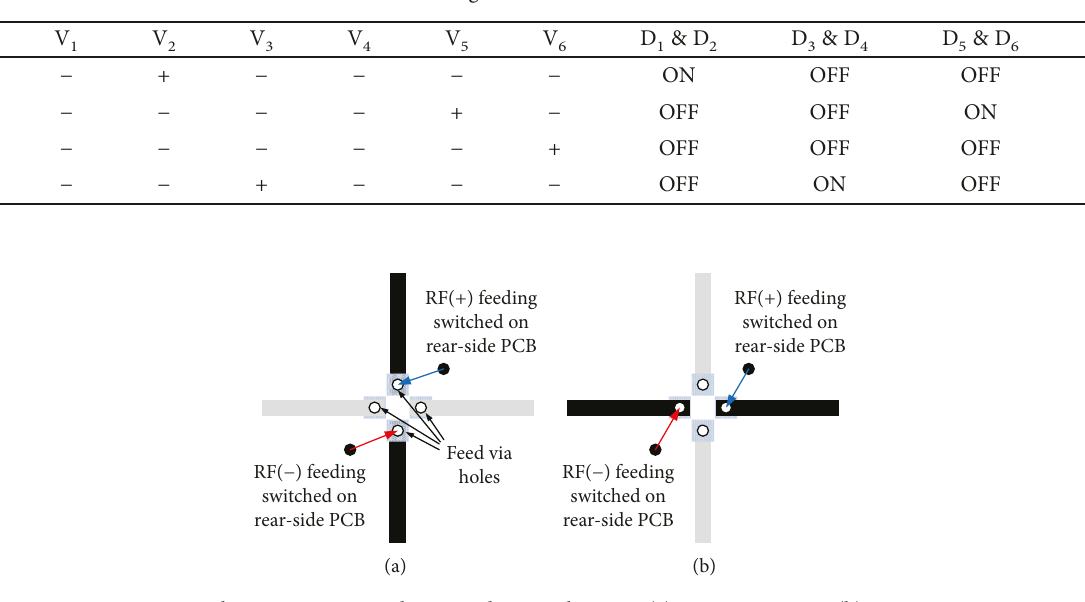
Figure 4: Con fi guration of the proposed planar ESPAR antenna system. Table 1: Control voltages for diode status and beam directions.